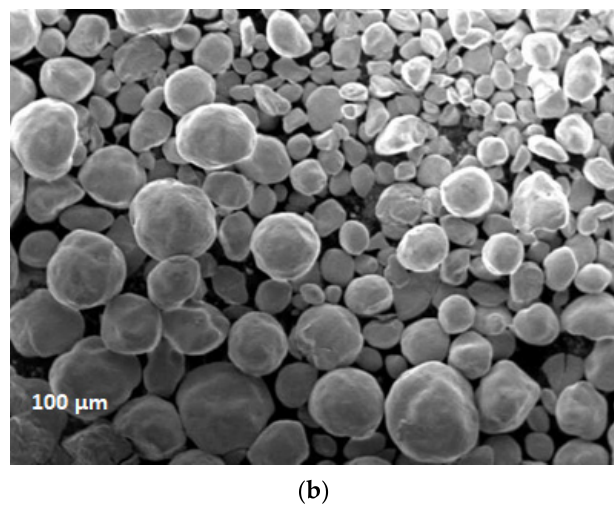
Figure 1. SEM images of ( a ) Coal Bottom Ash; ( b ) Silica Fume. Table 1. Properties of cement and coal bottom ash.